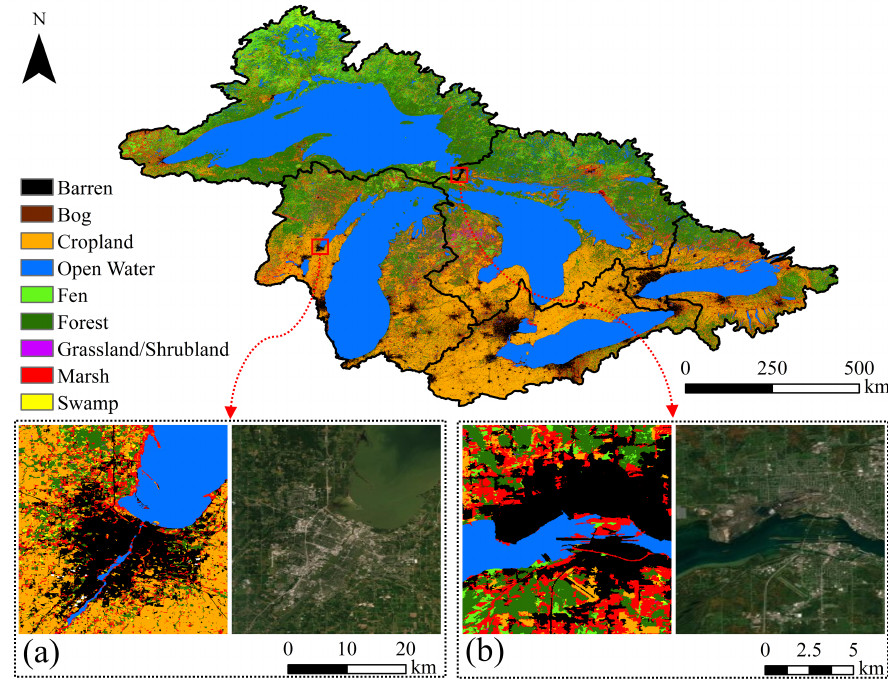
Figure 8. Generated wetland map of the Great Lakes basin using satellite imagery between 2020 and 2021 along with ( a , b ) two zoomed areas (wetland map and high-resolution satellite imagery) to illustrate the visual accuracy of the resultant